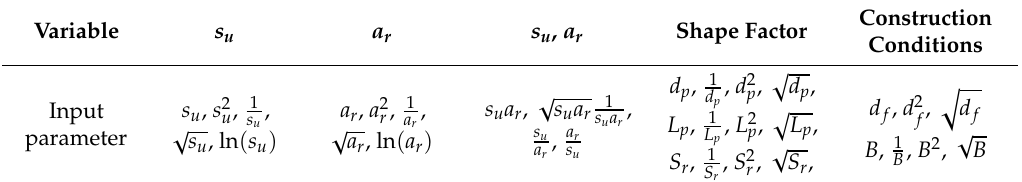
Table 2. Type of the input variables in the multiple linear regression